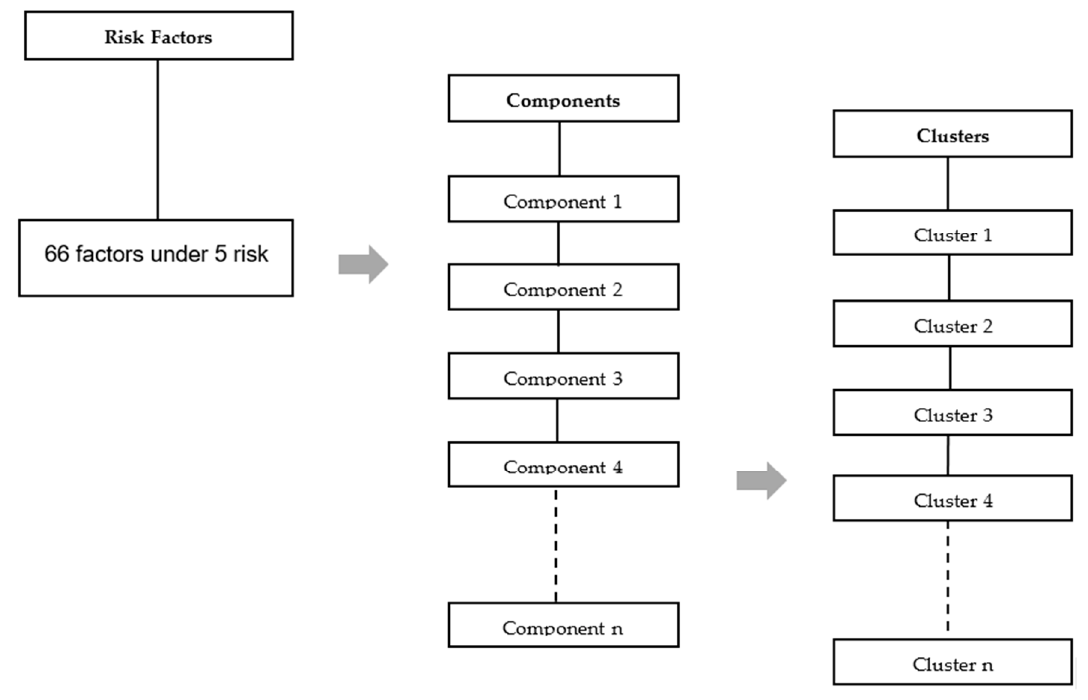
Figure 2. Factor analysis and data reduction process .